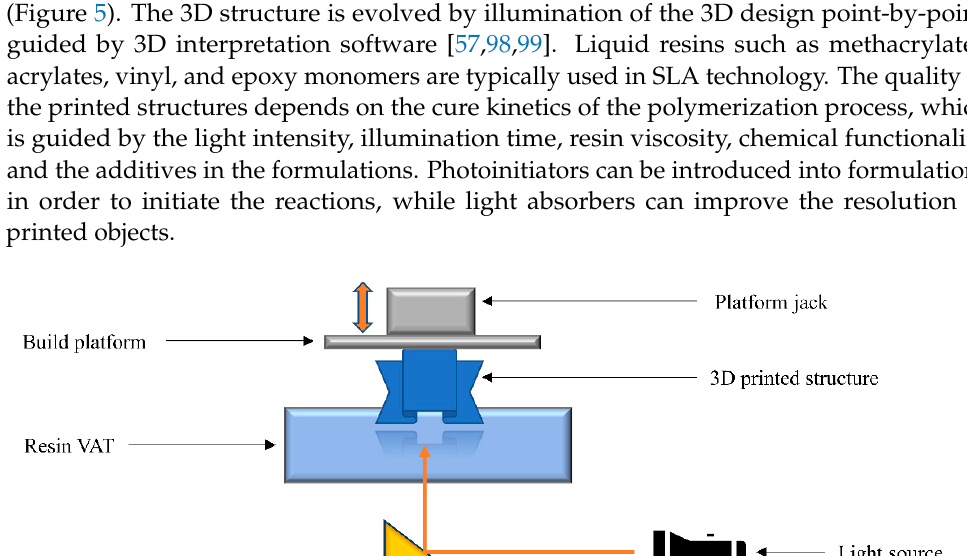
Figure 4. Schematic diagram of the selective laser sintering laser (SLS) process. Redrawn from [95].